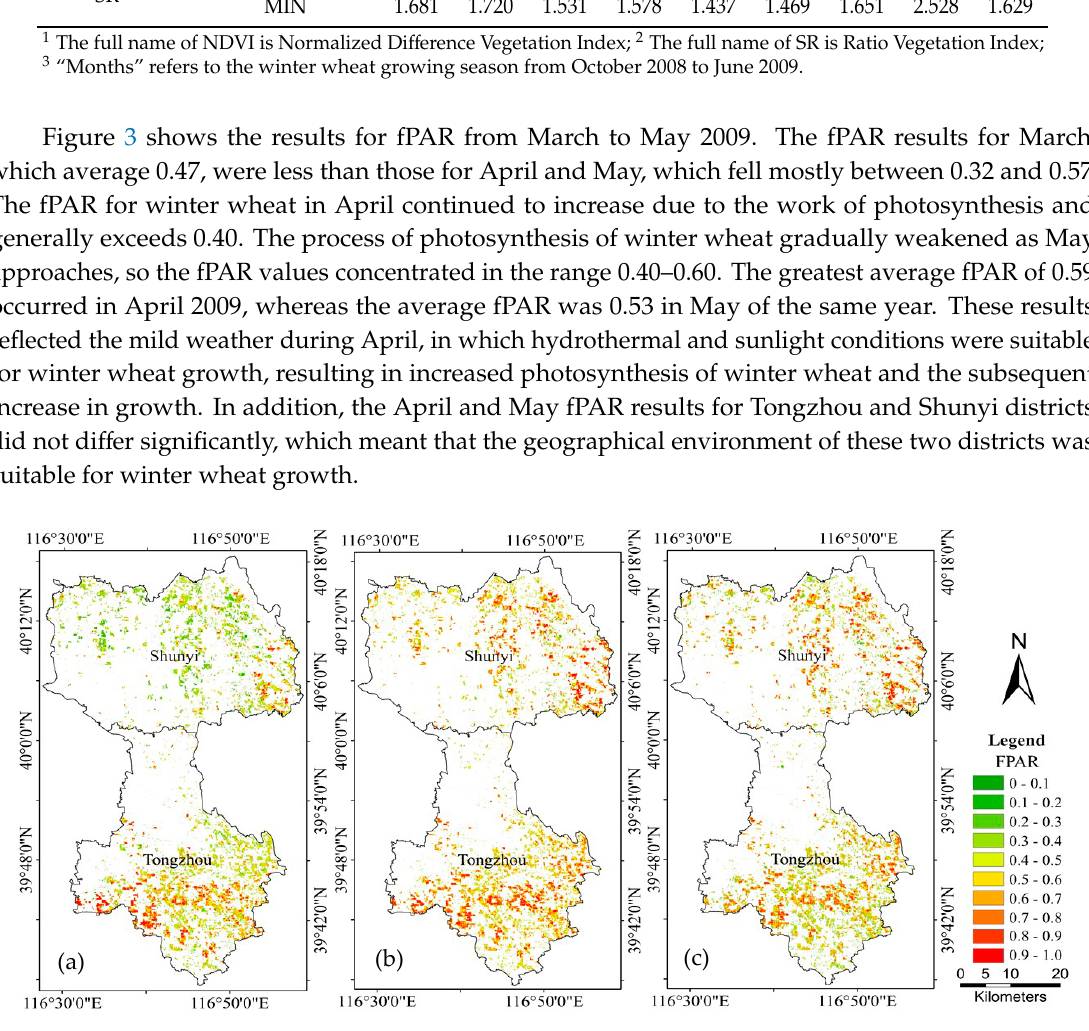
Table 1. NDVI and SR maximum and minimum values for winter wheat for each month of the growing season.